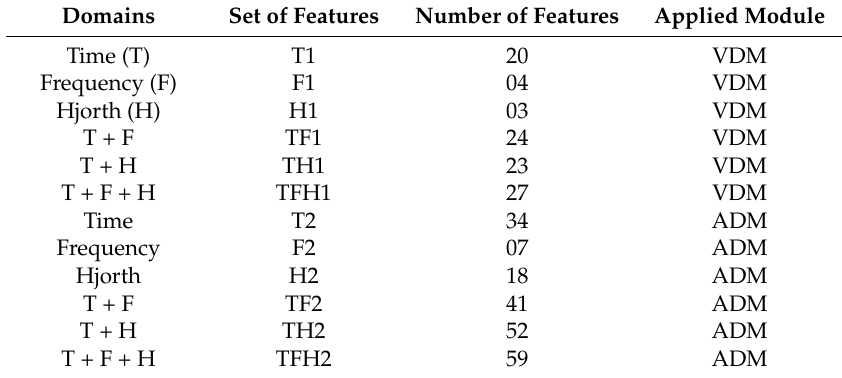
Table 4. Sets of features.